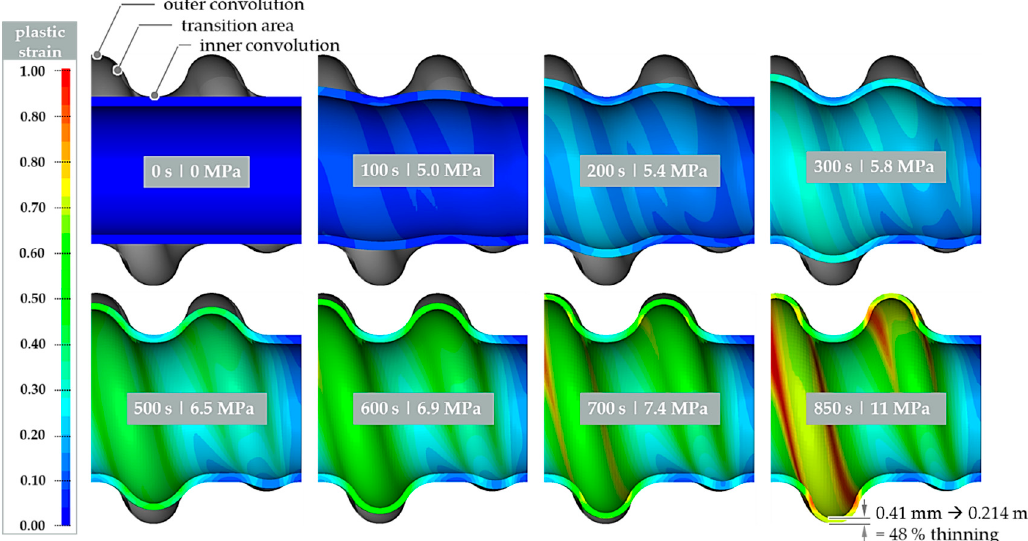
Figure 5. Longitudinal view of several stages of the part geometry during the forming process.